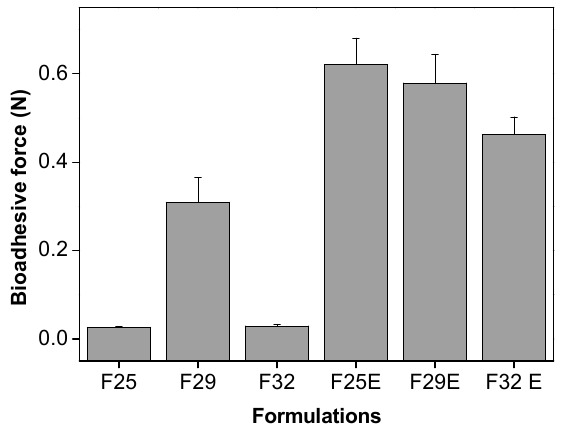
Figure 6. Bioadhesive force ( N ) of the formulations.